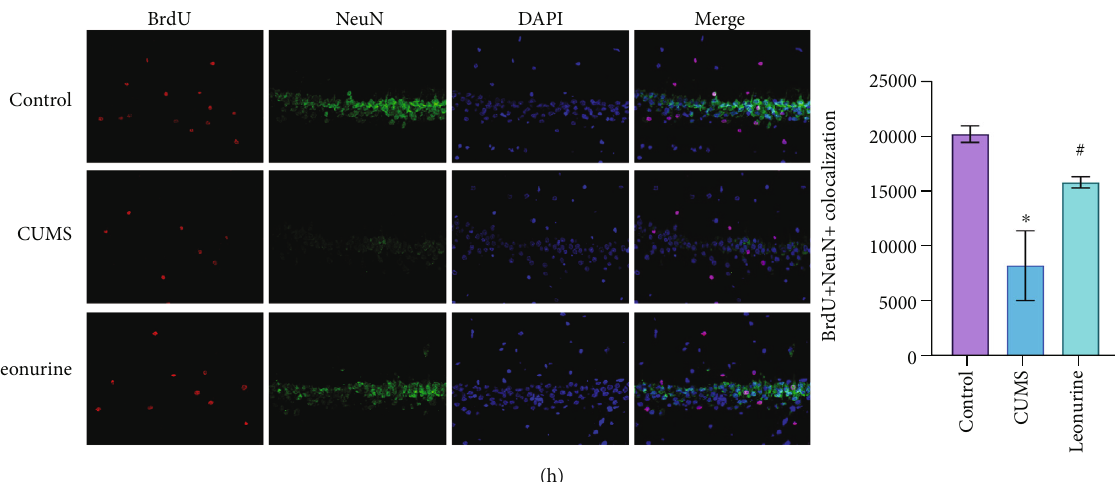
Figure 1: The e ff ects of leonurine on behavioral indexes, in fl ammation, and nerve regeneration in CUMS rats. (a) Rats body weight assessment. (b) SPT. (c) OFT. (d) FST. (e) HE detection of brain tissue morphology. (f) Western blot detection of BDNF and 5-HT expressions in the hippocampus. (g, h) IF detection of the colocalization of BrdU+DCX and BrdU+NeuN in the hippocampus. ∗ P < 0 : 05 vs. Control. # P < 0 : 05 vs.